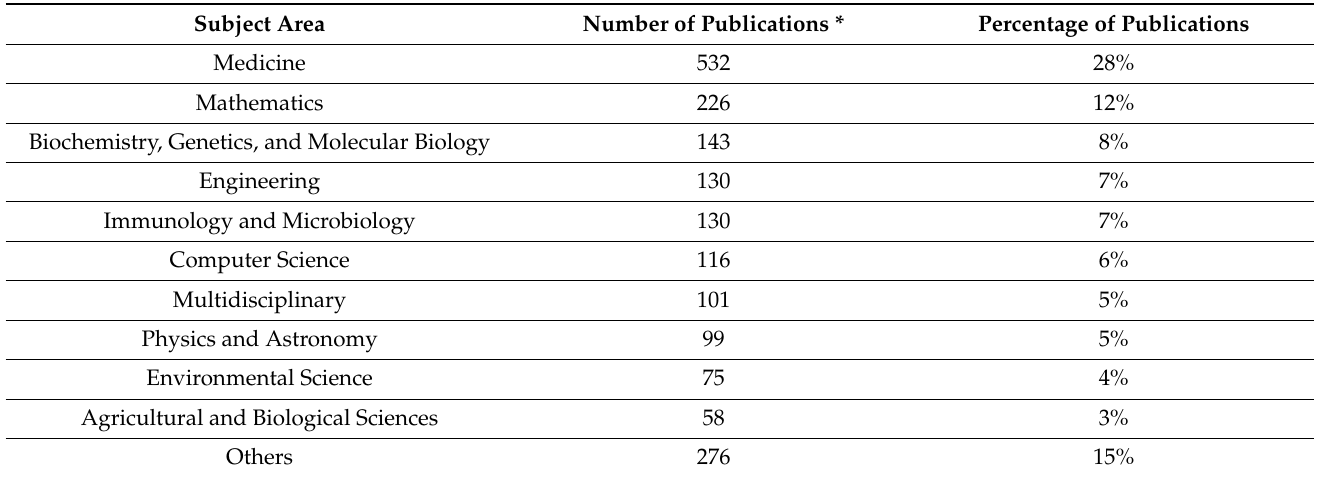
Table 2. Subject Areas of